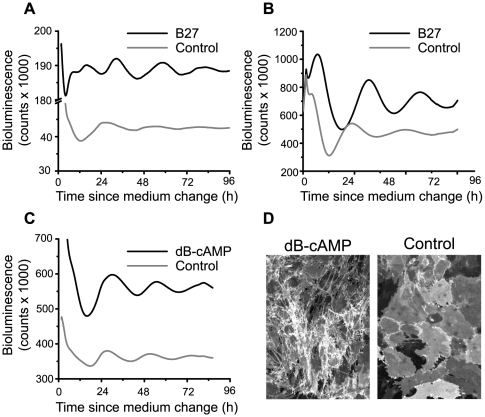
Circadian gene expression in astrocytes is modulated by culture conditions in vitro.A, Bioluminescence traces from rat Per1::luc cortical astrocytes. Supplementing the medium with B27 significantly increased Per1-driven bioluminescence levels and circadian rhythm amplitude (average of 2 cultures per traces). B, Bioluminescence traces from mouse PER2::LUC cortical glia showing higher bioluminescence levels and amplitude in the presence of B27 (average of 2 cultures per traces). C, Bioluminescence traces from rat cortical astrocytes showing that a 10-day treatment with dB-cAMP (250 µM) significantly increased Per1-driven bioluminescence levels and rhythm amplitude (average of 2 cultures per traces). D, Representative photomicrographs of GLAST immunofluorescence showing stellation of rat astrocytes induced by 250 µM dB-cAMP. Magnification = 10×.